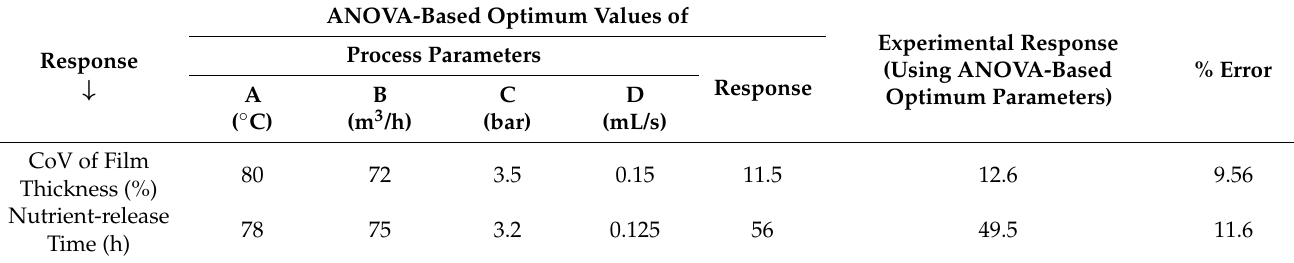
Table 5. Optimum process parameters, experimental response, and %